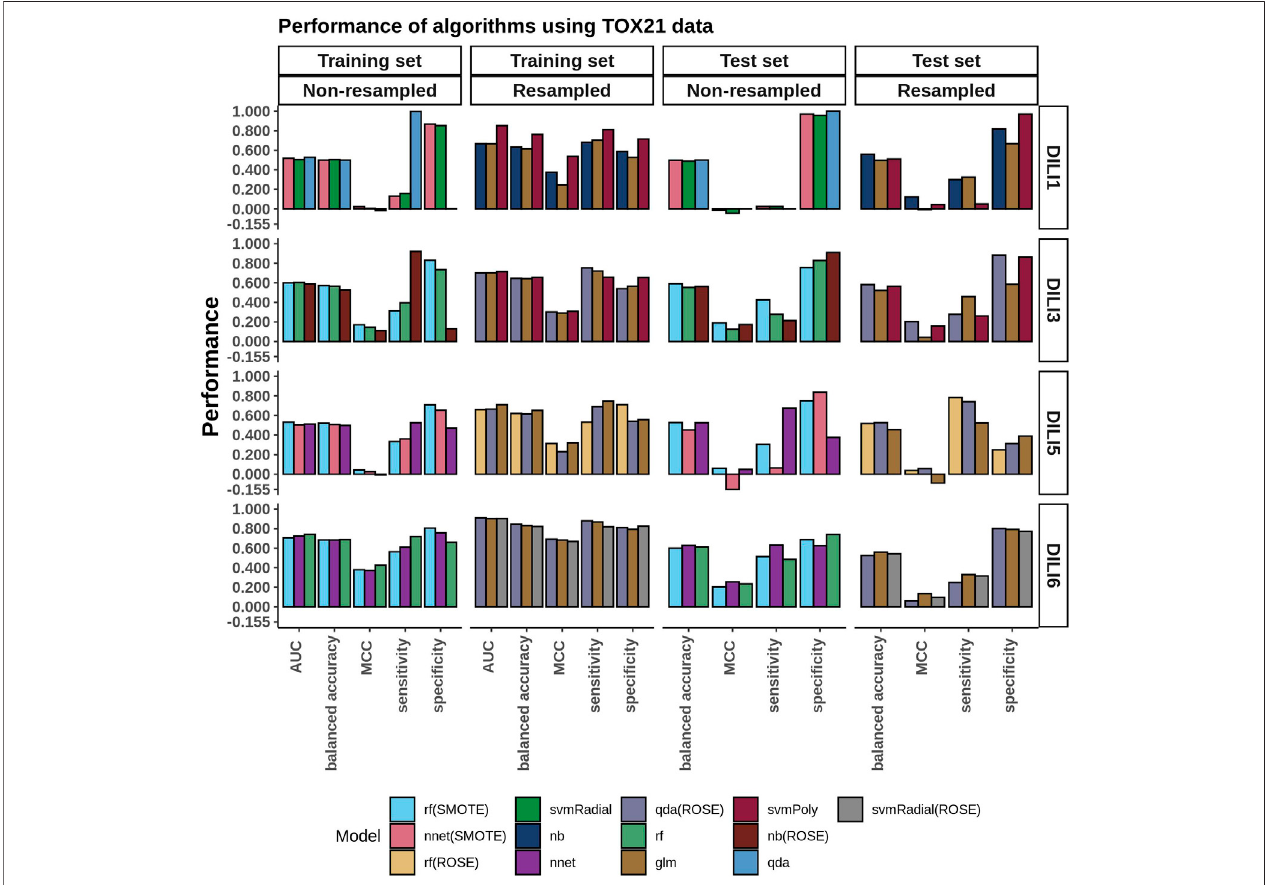
FIGURE 4 | TOX21 Model Performance. The performance of DILI predictive models built using the toxicology information provided from TOX21. The three best- performing algorithms, based on training AUC and based on whether resampling was used or not, are presented in the bar plots.